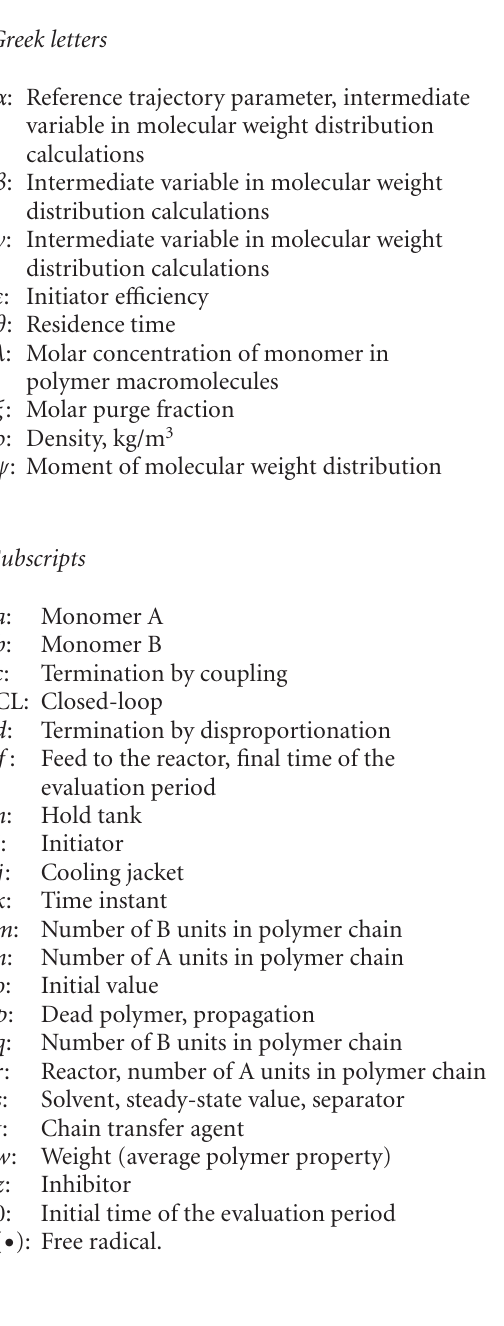
variable in molecular weight distribution calculations β : Intermediate variable in molecular weight distribution calculations γ : Intermediate variable in molecular weight distribution calculations ε : Initiator e ffi